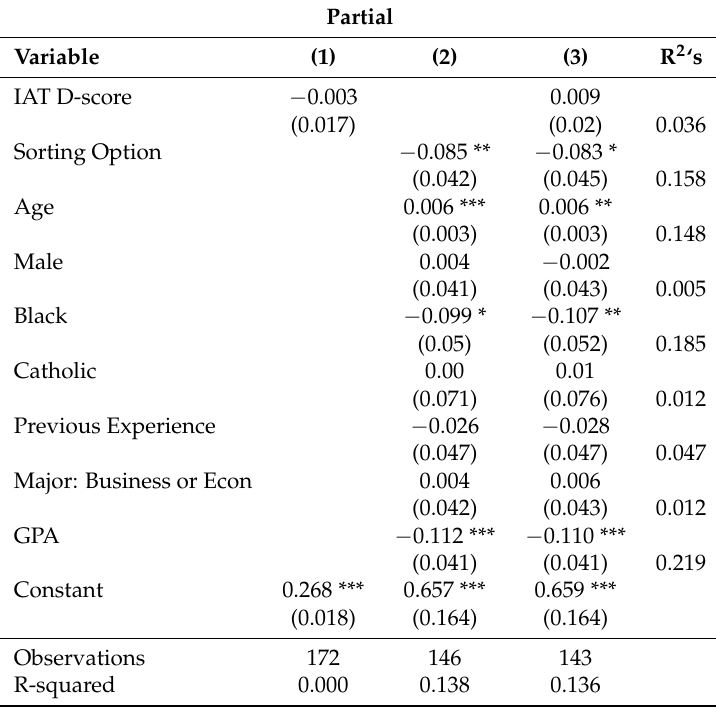
Table 8. Determinants of